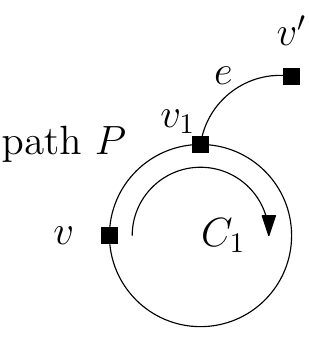
Figure 8 . A cycle C 1 around v .